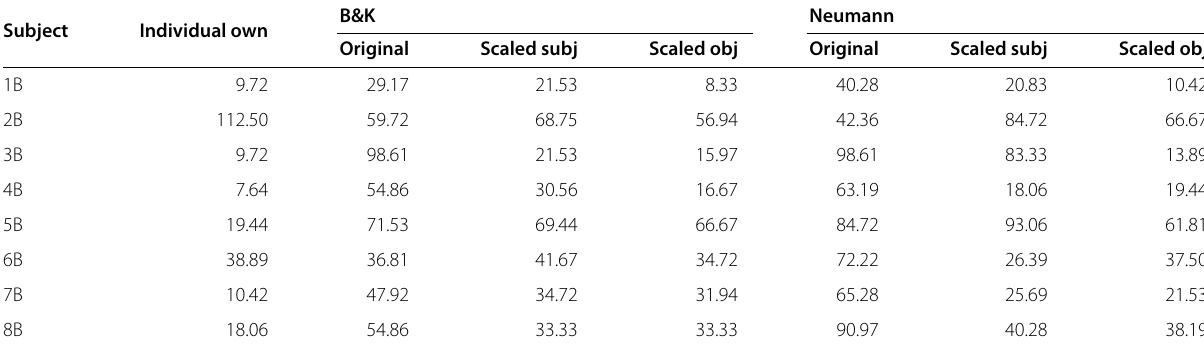
Table 8 MSE of the answers of the validation perceptual